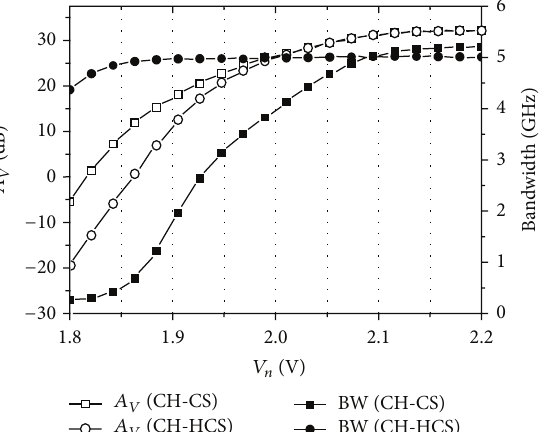
Figure 6: Comparison of voltage gain and its bandwidth of Cherry- Hooper amplifier with CS and HCS